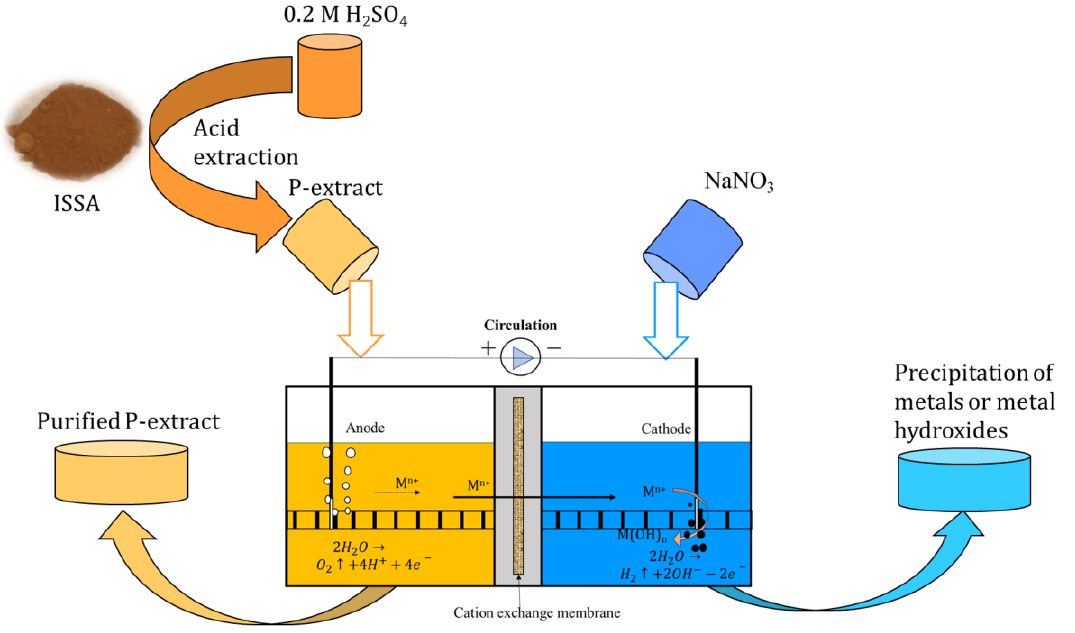
Figure 1. Schematic process of the electrodialytic process.